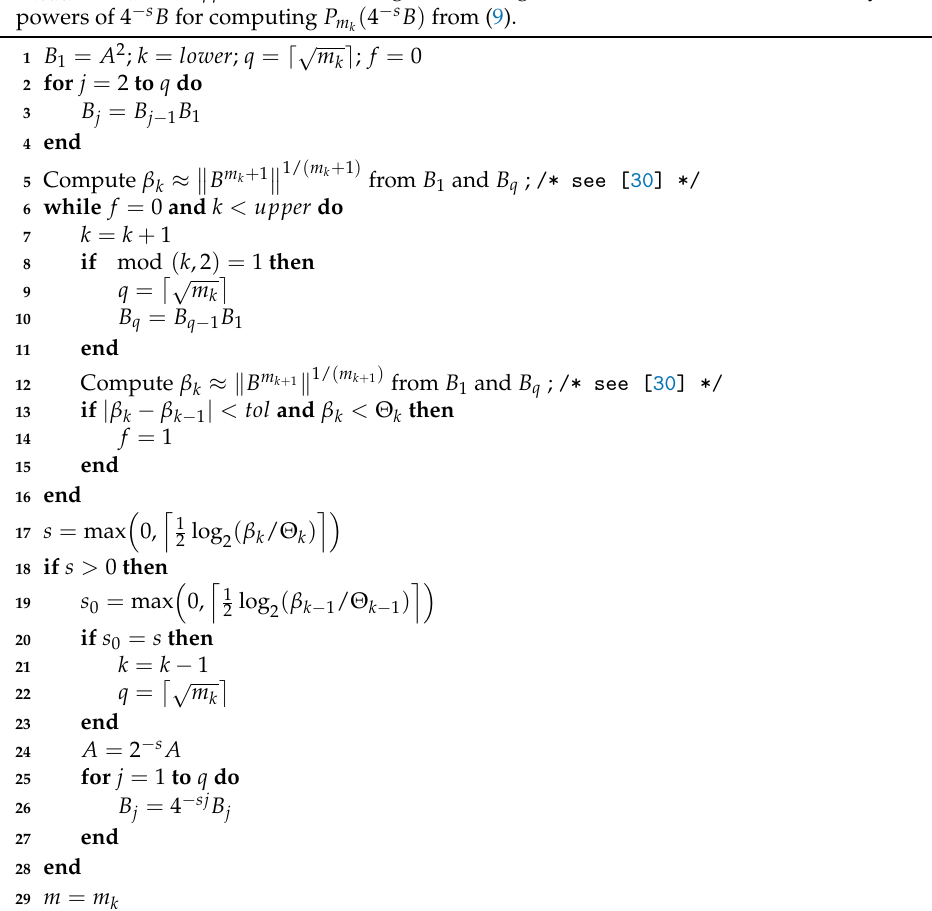
Algorithm 4: Given a matrix A ∈ C n × n , the values Θ from Table 1, a minimum order m lower ∈ M , a maximum order m upper ∈ M , with M = { 2,4,6,9,12,16,20,25,30 } , and a tolerance tol , this algorithm computes the order of Taylor approximation m ∈ M , m lower ≤ m k ≤ m upper , and the scaling factor s , together with 2 − s A and the